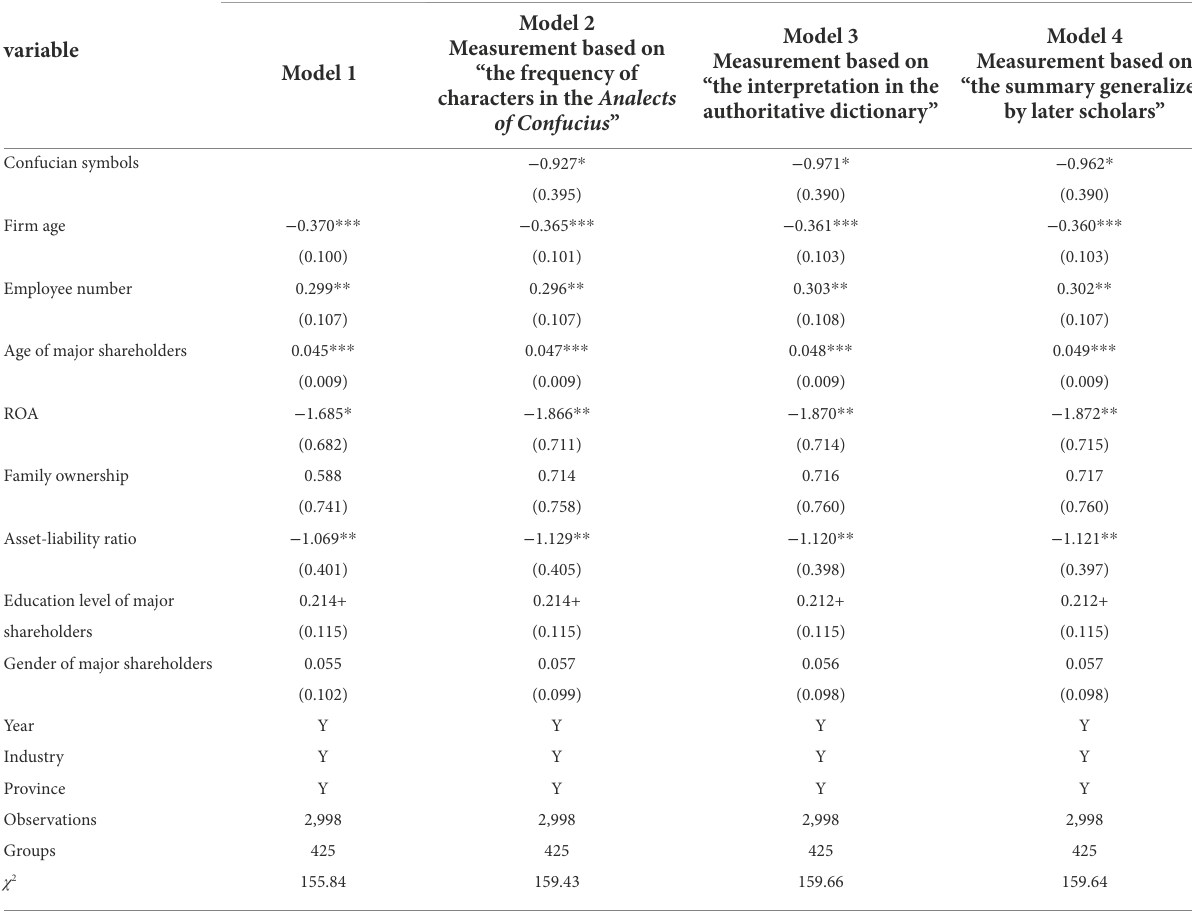
TABLE 3 The effect of Confucian symbols on CEO family